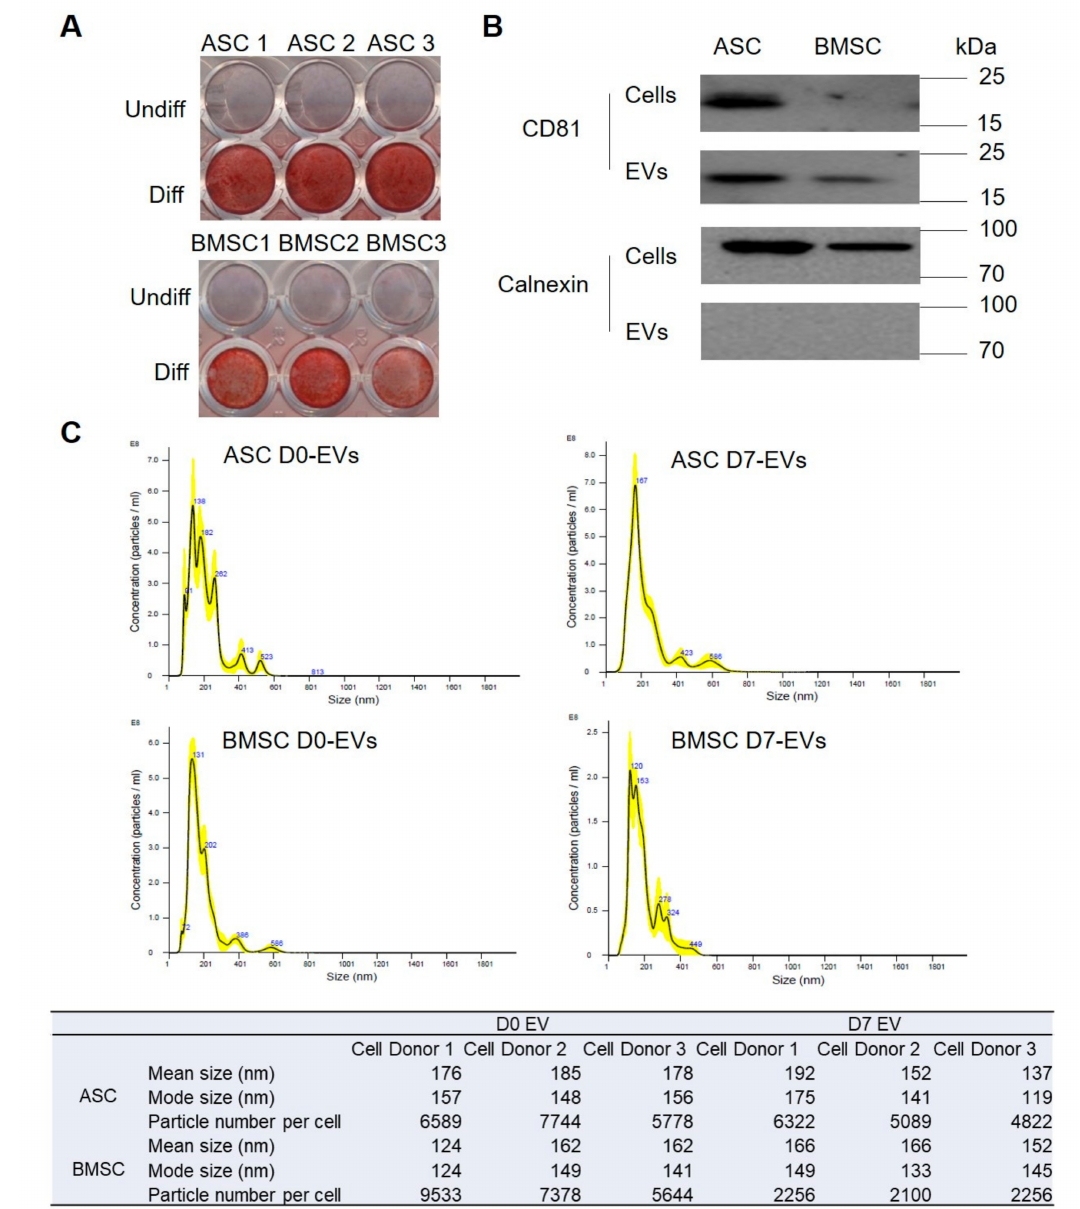
Figure 1. Characterization of extracellular vesicles (EVs) secreted from bone marrow stem cells (BMSCs) and adipose stem cells (ASCs). ( A ) Characterization of osteoblastic di ff erentiation using Alizarin red S (ARS) staining. ASC1, ASC2, ASC3 present ASCs from three di ff erent donors; BMSC1, BMSC2, BMSC3 represent BMSCs from three di ff erent donors. ( B ) characterization of EV markers using Western blot. Cells and EVs are pools from three donors. ( C ) Size distribution of EVs based on nanoparticle tracking analysis (NTA). The NTA result is shown of one of the three donors and the table below shows the NTA results of all the three donors. D0 represents the time just before osteoblastic di ff erentiation induced; D7 represents the day 7 of osteoblastic di ff